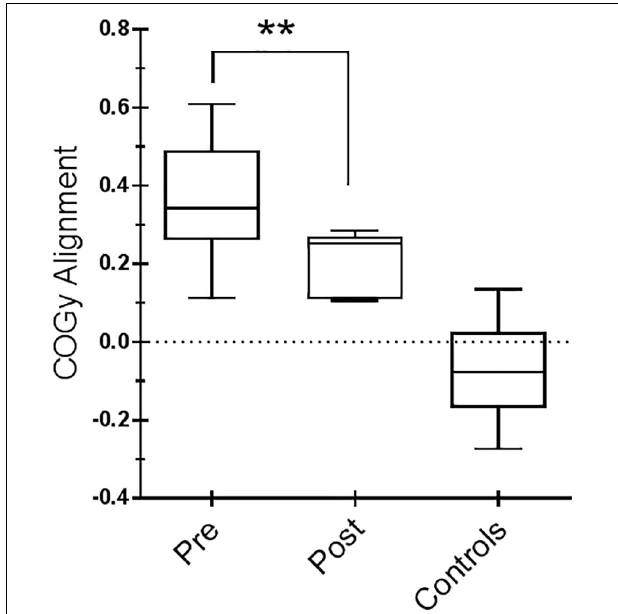
FIGURE 3 | Center of gravity (COG) alignment prior to the onset of the Sensory Organization Test (SOT) conditions and control values. Box and whiskers represent minimum, maximum, median, and 25th and 75th percentiles. Posttraining, a more accurate alignment of the center of gravity relative to the base of support is shown. Statistical analysis is performed between pretraining and posttraining only in Parkinson’s disease (PD) subjects. ∗∗ p = 0.01 (Wilcoxon matched-pairs signed rank